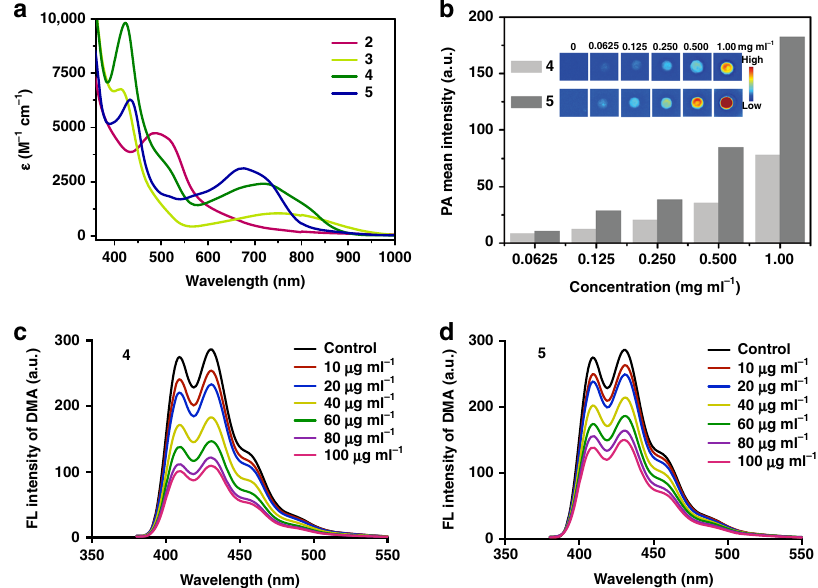
Fig. 6 Properties of chelates with N/C coordination environments. a Ultraviolet – visible (UV – vis) absorption spectra of complexes 2 – 5 measured in CH 2 Cl 2 at room temperature. b Photoacoustic (PA) mean intensities of 4 and 5 at different concentrations (0.0625, 0.125, 0.250, 0.500, and 1.00 mg ml − 1 ) in MeCN monitored at λ = 700 nm (Inset: PA imaging). c , d Assessment of the generation of reactive oxygen species (ROS) by 4 and 5 at different concentrations (10, 20, 40, 60, 80, and 100 μ g ml − 1 in CH 2 Cl 2 ) when activated by ultrasound (US) (1 MHz, 0.56 W cm − 2 , 50% cycle, 5 min). FL: fl uorescence; DMA: